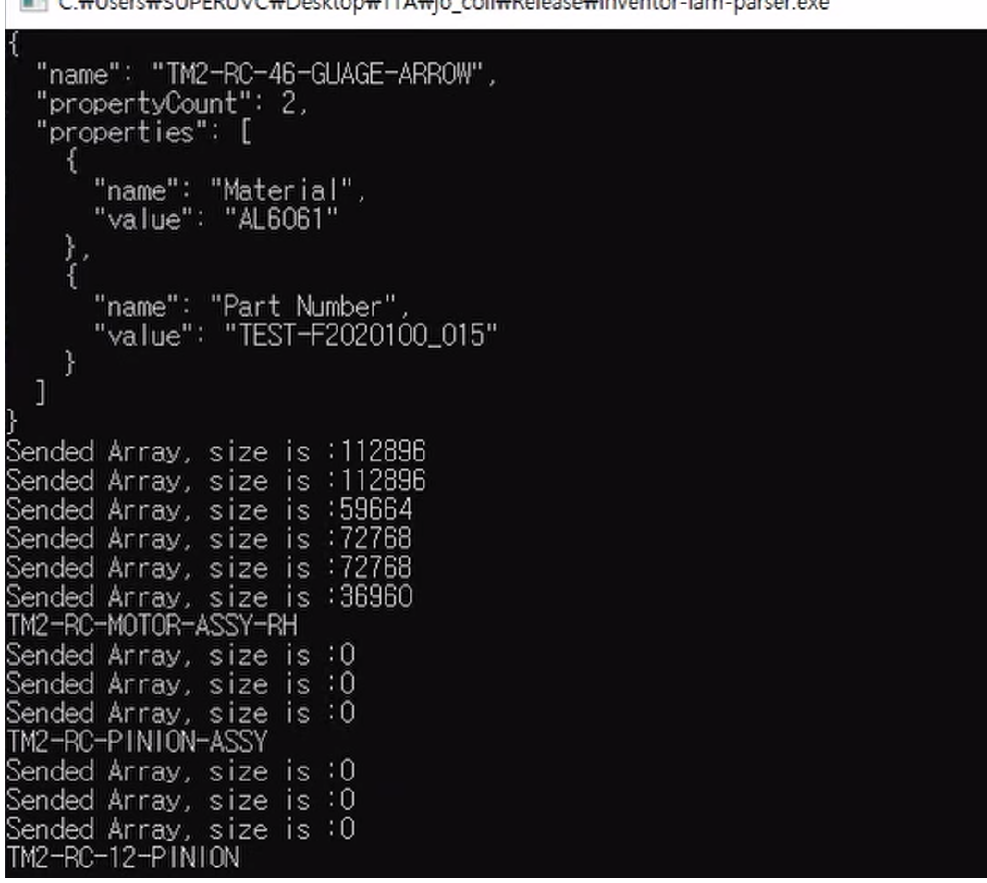
Figure 8. Smart connector and VR